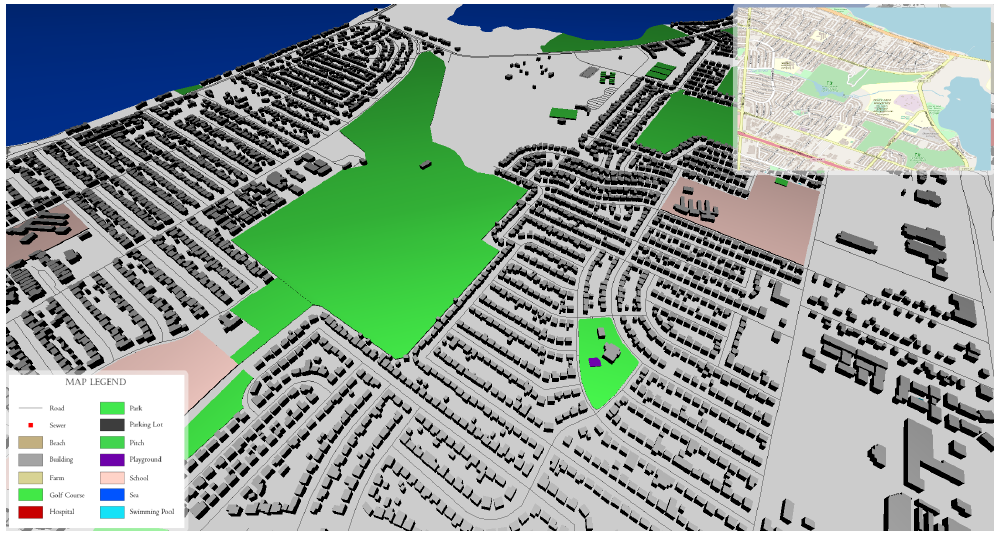
Figure 7. 3D shaded visualization of parts of Corpus